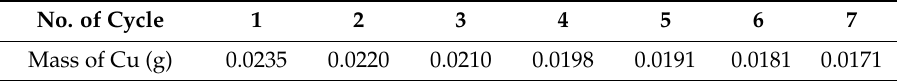
Figure 1. ( a ) Schematic image of chemical etching process of Cu without eliminating graphene below Cu. ( b ) Schematic image of chemical etching process of Cu after plasma etching for graphene below Cu. ( c ) Schematic image of bubble transfer method. Table 1. Mass of the Cu during 7 cycles of CVD process. Table 1. Mass of the Cu during 7 cycles of CVD